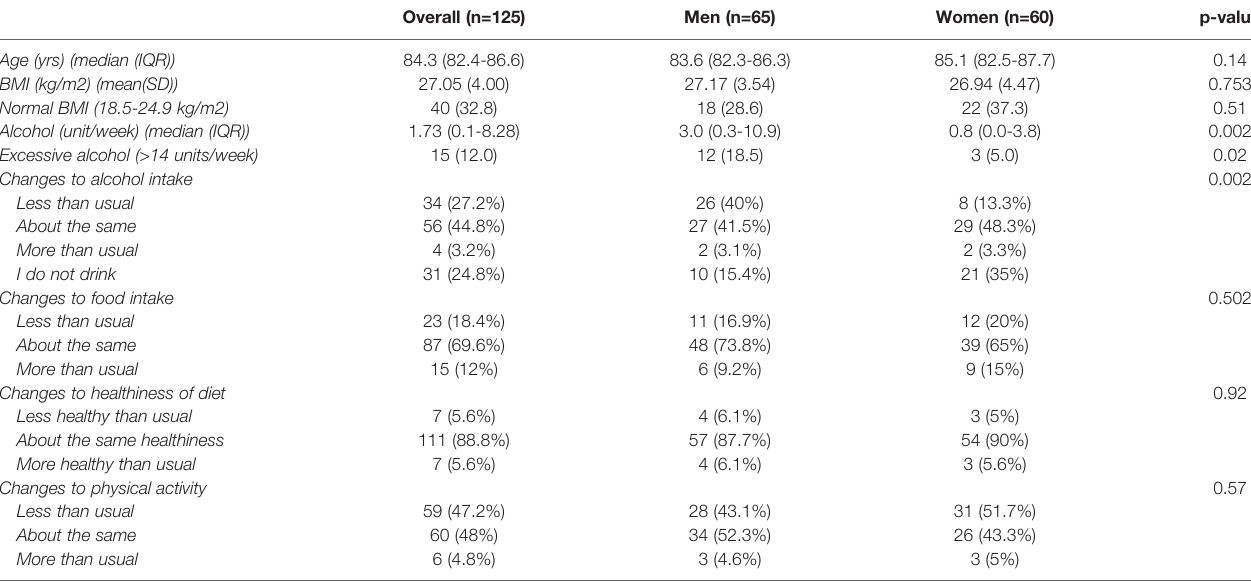
TABLE 1 | HCS participants ’ characteristics and self-reported lifestyle changes compared to pre-pandemic times.* Overall (n=125) Men (n=65) Women (n=60) p-value Age (yrs) (median